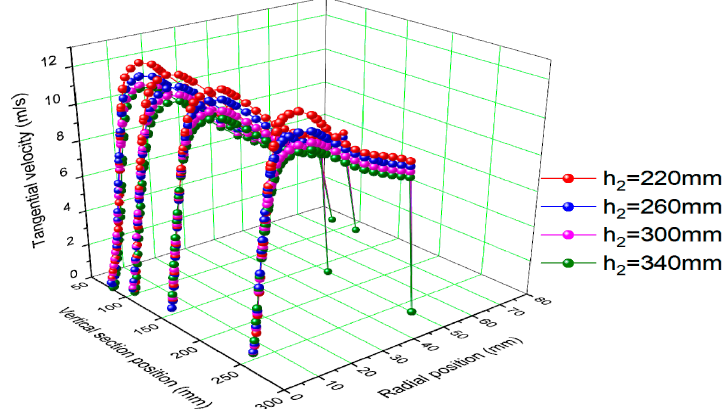
Figure 8. Distribution curve of tangential velocity.